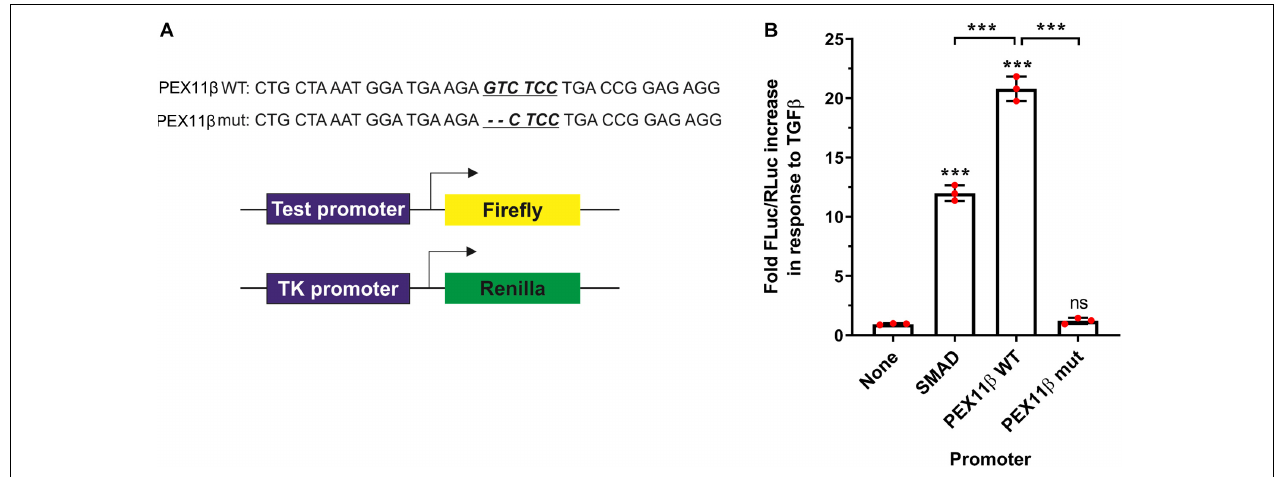
FIGURE 8 | TGF β activates PEX11 β expression by direct binding of the SMAD2/3 transcription factor to the PEX11 β promoter. Luciferase reporter assays in HepG2 cells transfected with a Firefly-Luc reporter under the control of a SMAD2/3 motif-containing promoter (‘SMAD’); or PEX11 β wild type (‘WT’) or SMAD2/3 mutant (‘mut’) promoter. As a control, a promoter-less Firefly-Luc vector was used. Cells were treated with TGF β (2 ng/ml) or left untreated. (A) Schematic of the reporter vectors used. The potential SMAD2/3 binding motif (underlined) in the PEX11 β promoter and the deleted base pairs are indicated. pRL-TK construct with thymidine kinase promoter upstream of Renilla luciferase was used as an internal control in all the experiments. (B) Quantitative analysis of the effect of TGF β on promoter activity. Firefly luciferase activity (FLuc) was first normalized to Renilla luciferase activity (RLuc) in each condition. Fold increase in response to TGF β was then calculated by normalizing the relative luminometer unit values for each construct in the presence of TGF β to the value without TGF β . Data from 3 independent experiments; analyzed by one-way ANOVA with Tukey’s post hoc test; ns non-significant, *** p <